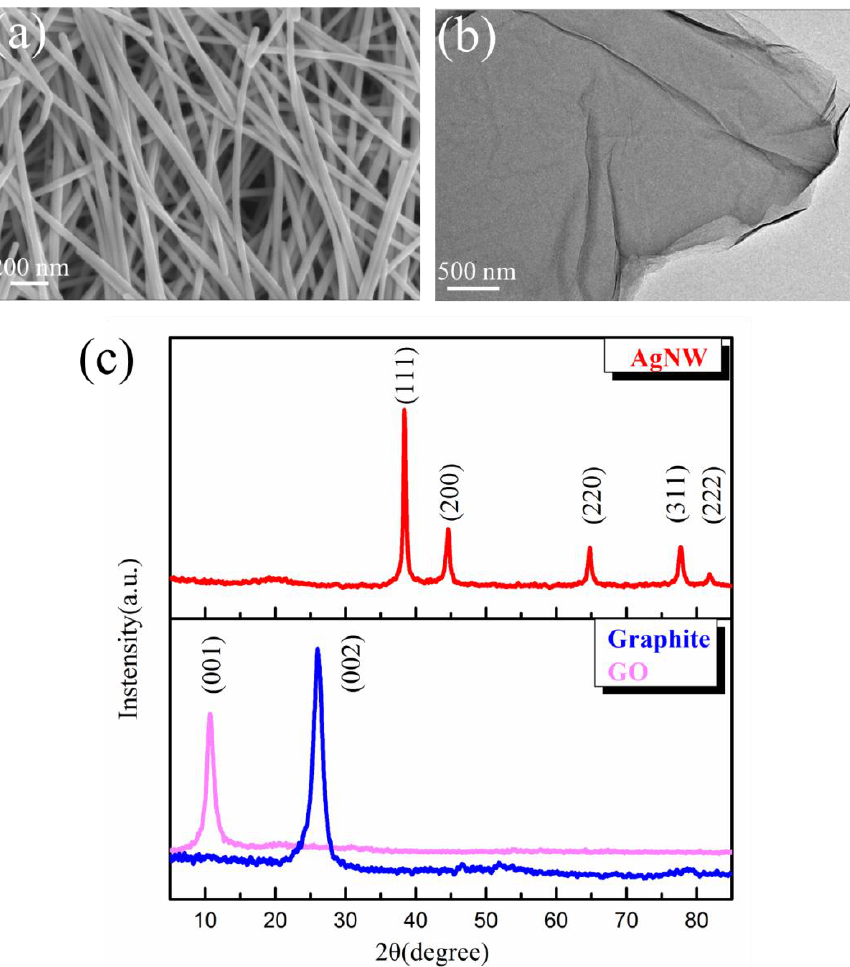
Figure 2. ( a ) SEM image of prepared silver nanowires (AgNWs). ( b ) TEM image of prepared graphene oxide (GO) nanosheets. ( c ) XRD patterns of AgNWs, graphite, and GO nanosheets.